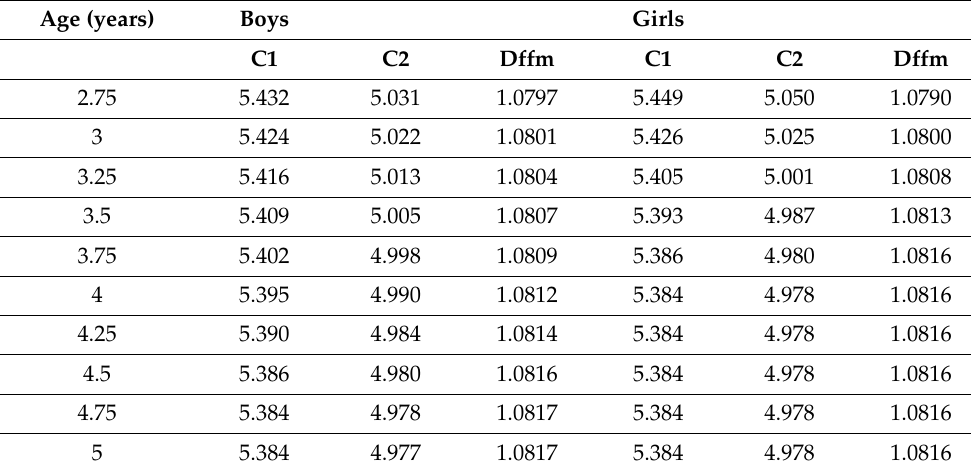
Table 3. Revised fat-free mass density models for children aged 3–5 years.